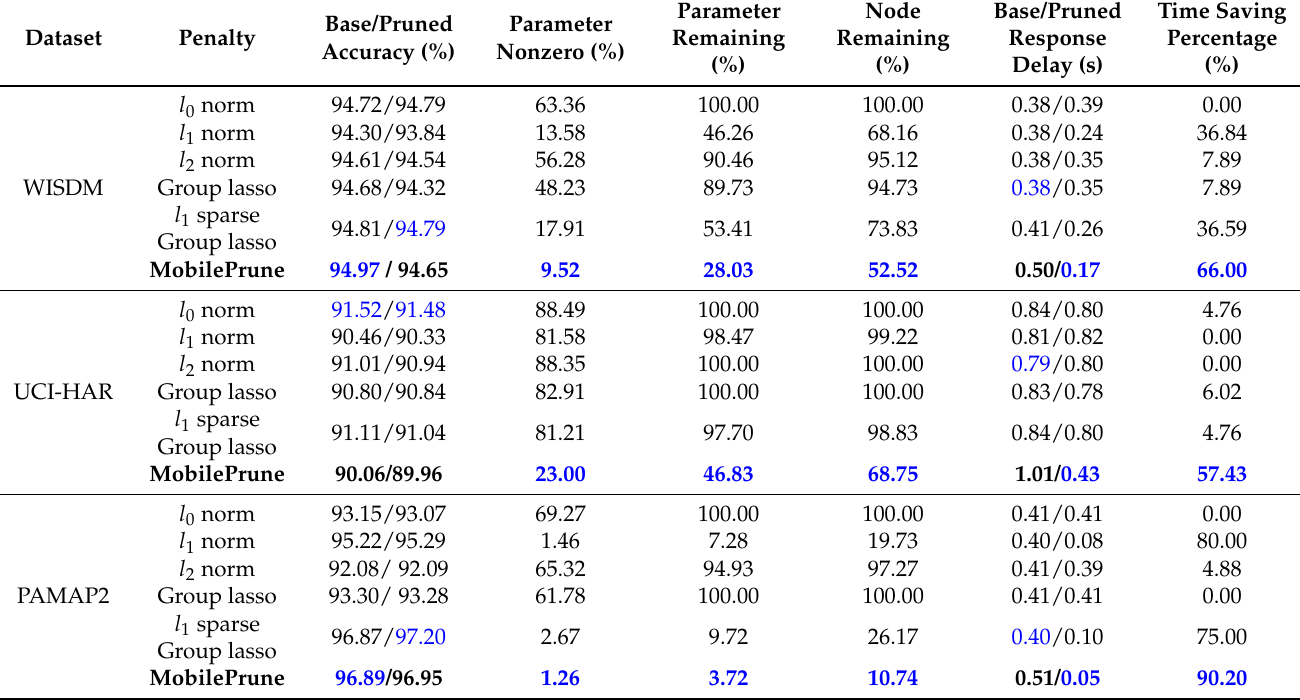
Table 2. Comparison of pruningmethod on the desktop with state-of-the-art methods for pruning accuracy, pruning rate and response delay on HAR datasets—WISDM, HCI-HAR, and PAMAP2, respectively. (We highlight our MobilePrune results and mark the best performance as blue among different penalties for each